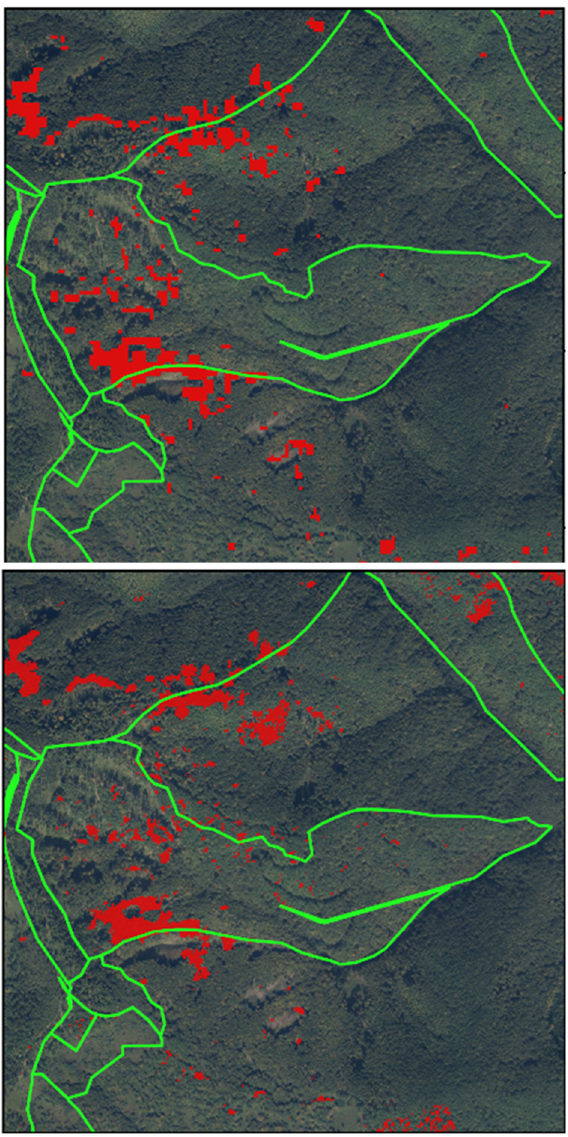
Figure 6. Automatically forest degradation map based on S2 10-m imagery (above) and 3-m forest degradation map (below) for forest compartment/subcompartment 19B (base map: digital orthophoto map).